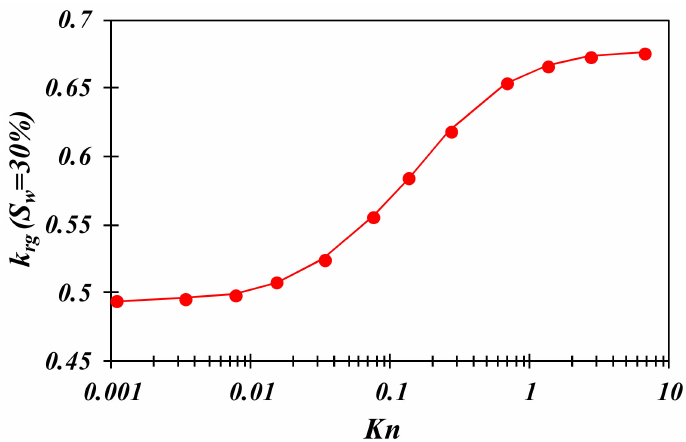
Figure 14. Relationship between k rg and Kn at S w = 30% (slit pore